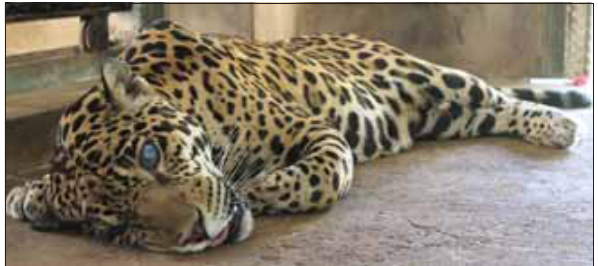
Figure-1: Immobilized jaguar ( Panthera onca ) with xylazine (1.0 mg/kg body weight [B.W]) and ketamine (3.5 mg/kg